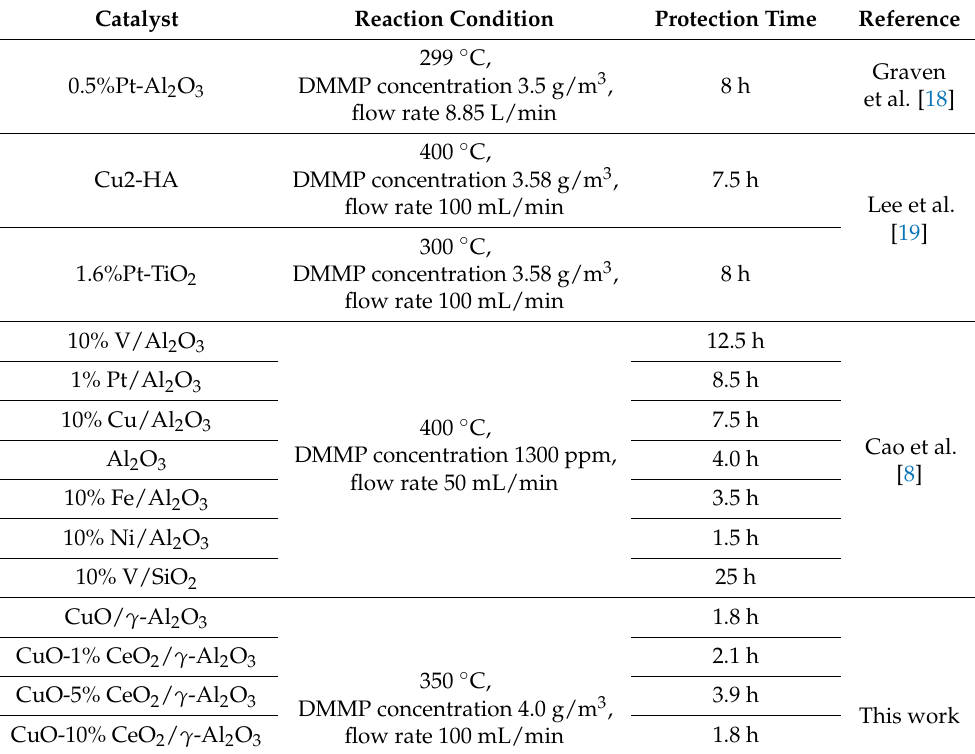
Table 1. A comparison of protection time on various